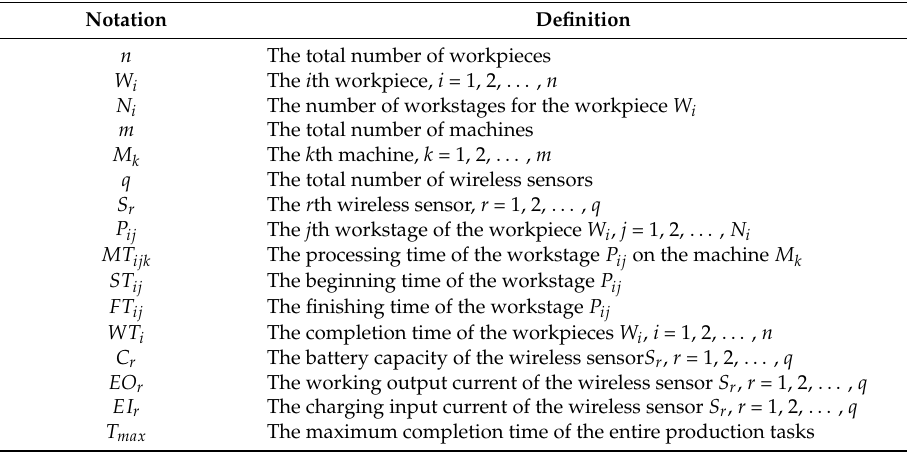
Table 1. List of Notations for